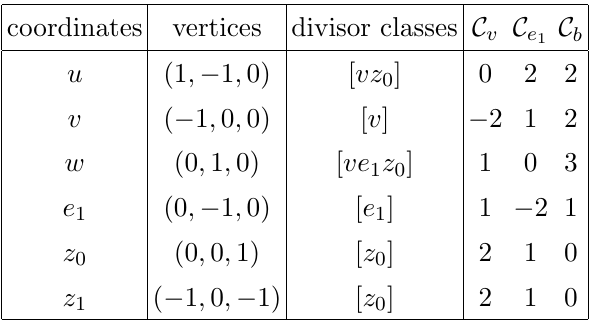
Table 2 . Coordinates, vertices, divisor classes and intersection numbers (charges of C (cid:3) -actions) for the three-dimensional toric variety dP 1 (cid:12)bered over P 1